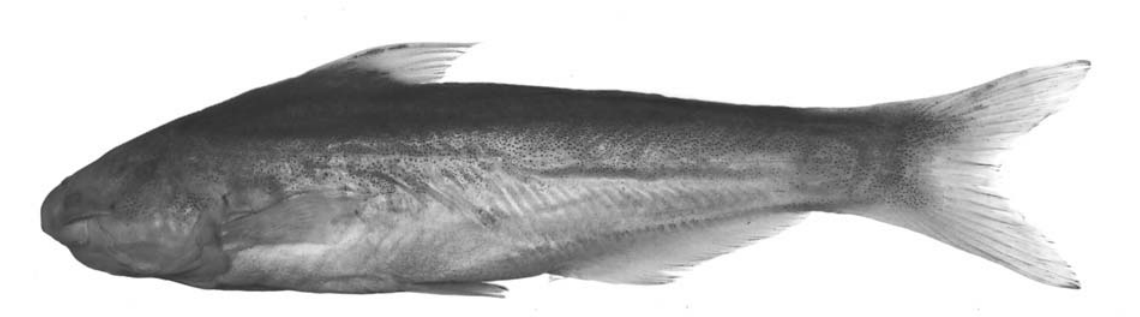
Fig. 14. Cetopsis baudoensis , NRM 27738, 98 mm SL; Colombia, Choco, río Baudó drainage, Boca de Pepé, various tributaries and river close to village (5°04’N,